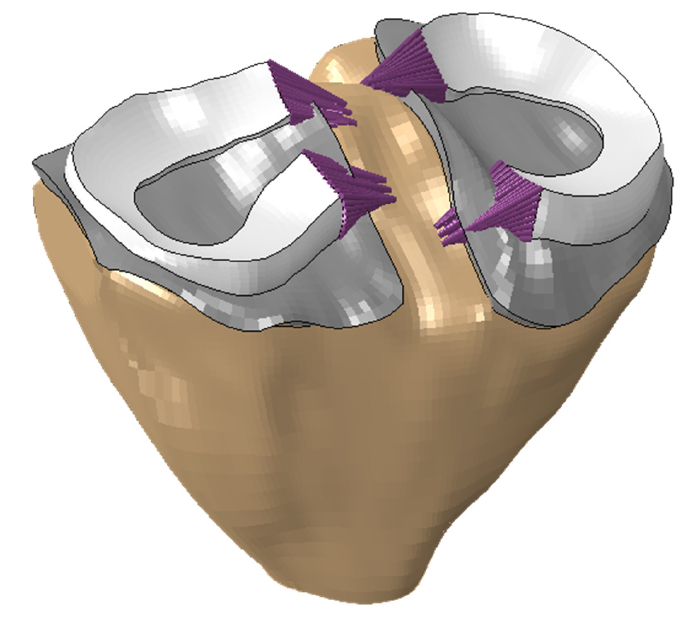
Figure 1. Tibia, tibial cartilage, menisci and menisci